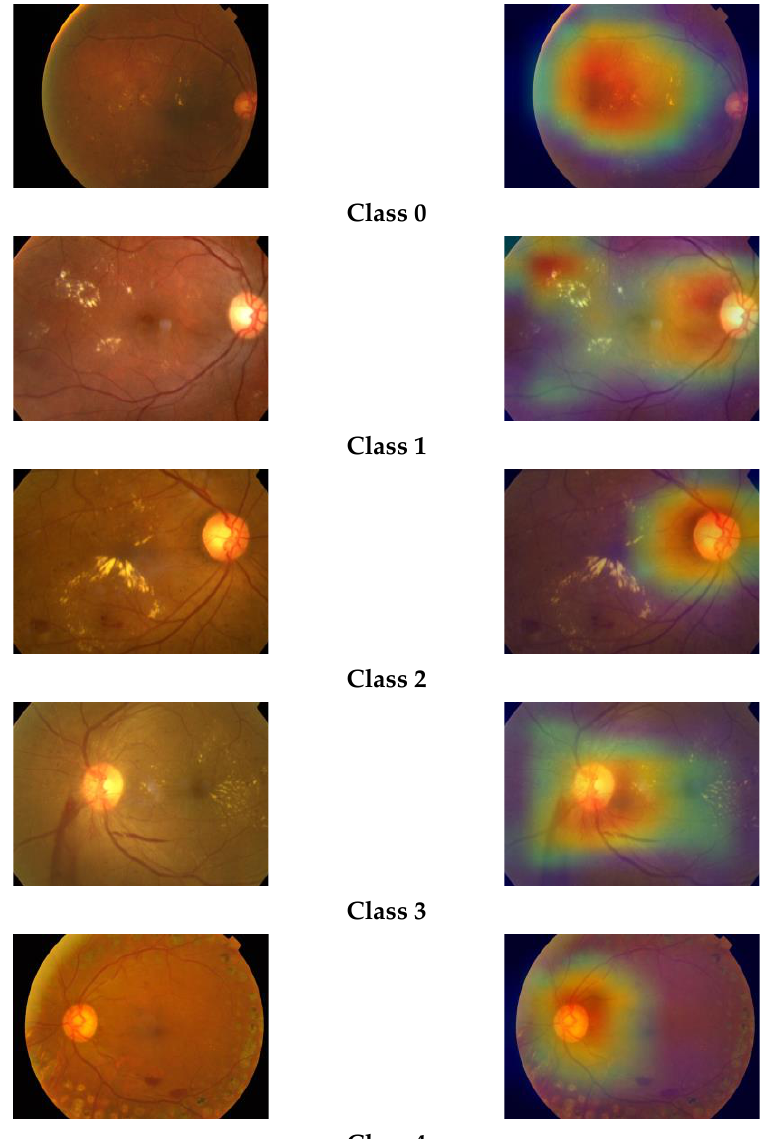
Figure 8. Grad-CAM visualizations of retinal images.